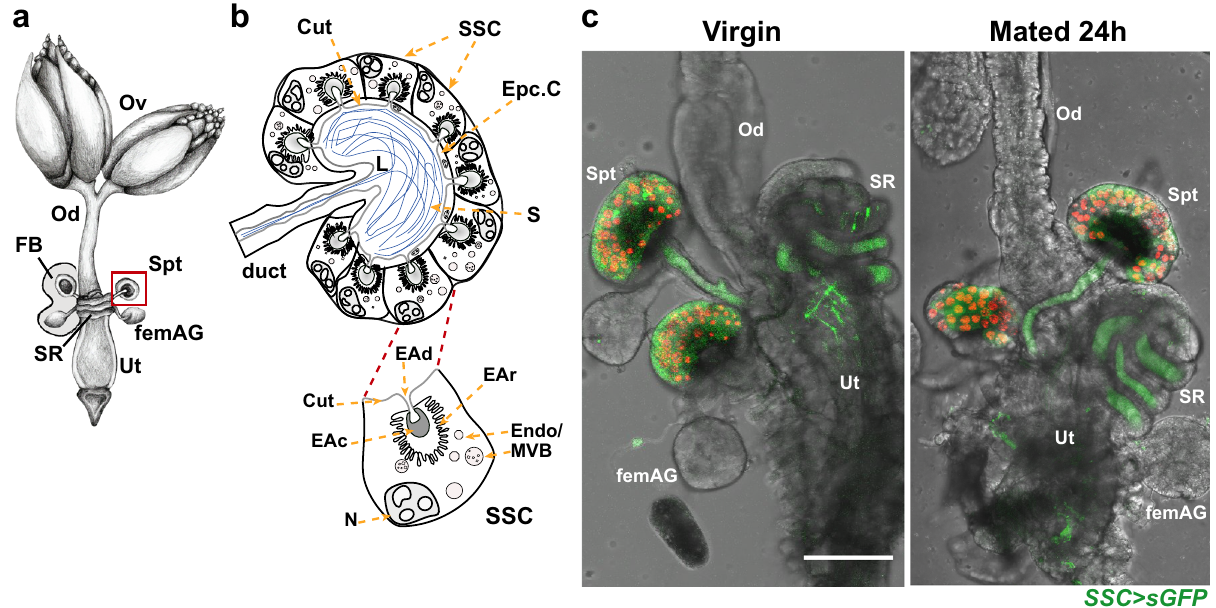
Fig. 1 Secretions produced by the spermathecal-secretory cells (SSC) reach the seminal receptacle and uterus. a Schematic of the female reproductive tract (female-RT; adapted from Avila, F.W. et al. 6 ). The female-RT is composed of ovaries (Ov), oviduct (Od), seminal receptacle (SR) and a pair of spermathecae (Spt), where sperm is stored, a pair of female accessory glands (femAG), and a uterus (Ut). b Schematic of spermatheca (red square in a ) displaying the spermatheca secretory cells (SSC) radially organized around a lumen (L) where sperm (S) is stored. The lumen is lined by dark chitin cuticle (Cut) and epicuticular cells (Epc.C). Each SSC displays a nucleus (N), endosomes (Endo), multivesicular bodies (MVB) and an end apparatus (EA), a specialized structure formed by a reservoir of convoluted membrane (EAr), a cuticular porous cavity (EAc) and a duct (EAd) through which secretions are secreted to the lumen. c Representative confocal maximum projection images of the female -RT that speci fi cally expressed the secreted form of GFP (Send1 > sGFP, here after SSC > sGFP) in the SSC. The nuclei of the SSC are observed as nRFP (scale bar = 100 µ